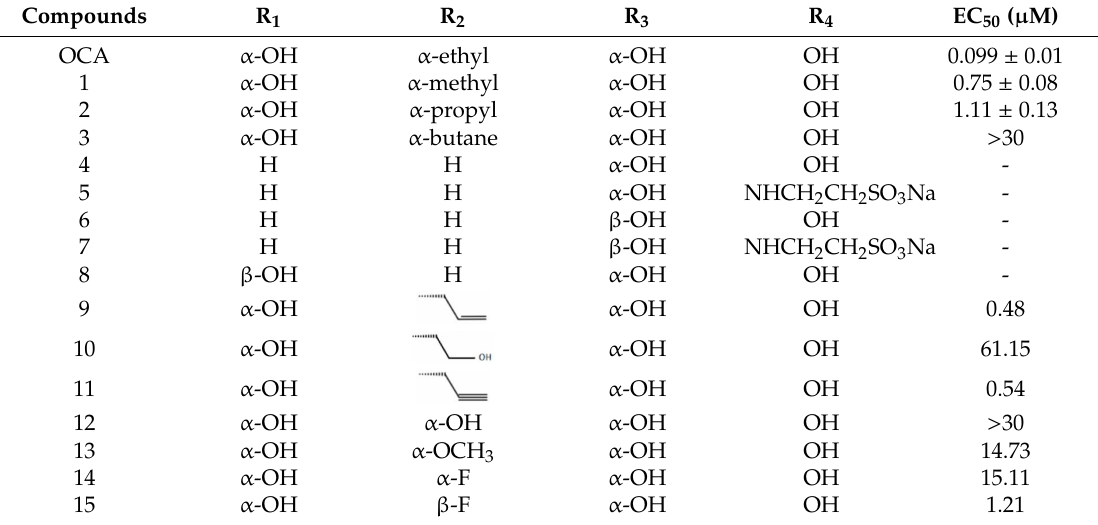
Figure 2. 2D image of the changes to bile acids sca ff old reported in Table 1. Table 1. Modifications made on bile acids sca ff